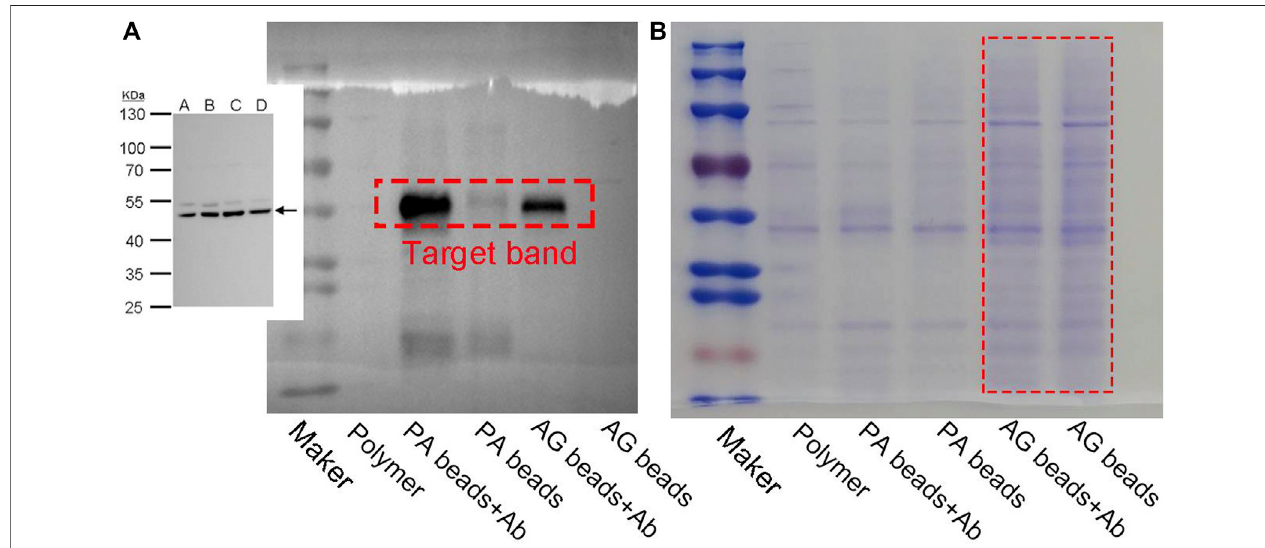
FIGURE 4 | The Western blot (A) and Coomassie blue staining (B) plot of protein enrichment using protein A modi fi ed PEN-NC microparticles (AP beads) and commercially available AG